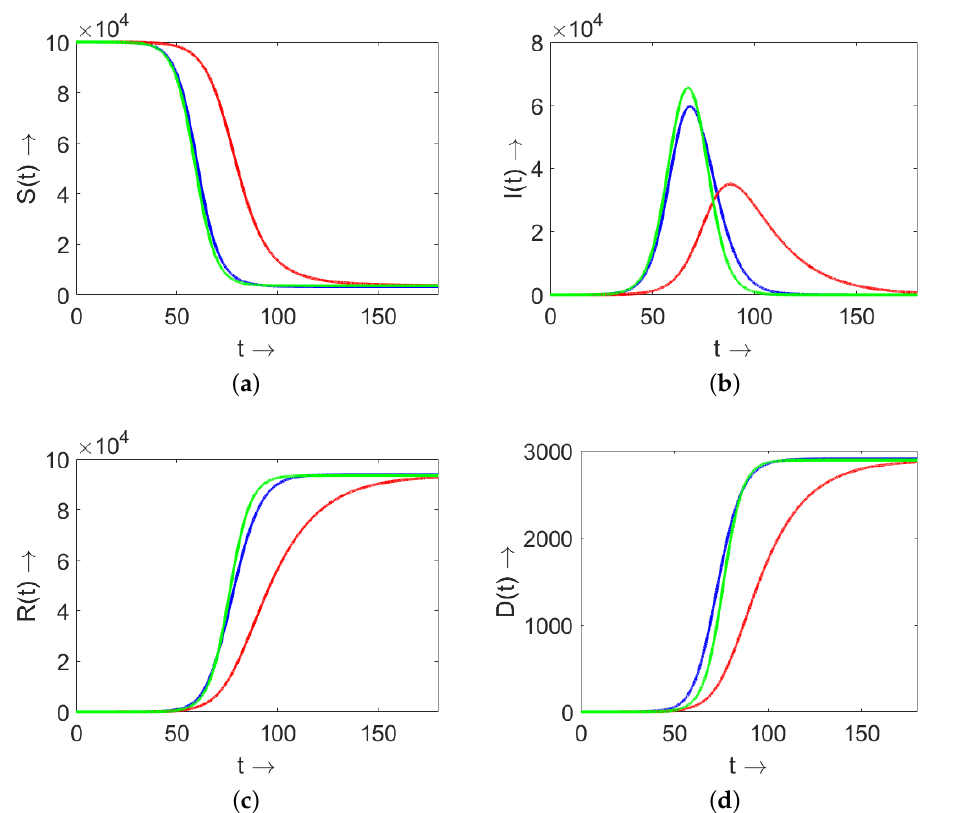
Figure 4. Comparison of the solutions of the distributed model (3) (blue curve), the delay model (9) (green curve), and the conventional SIR model (4) (red curve). ( a ) Susceptible S ( t ) , ( b ) infected I ( t ) , ( c ) recovered R ( t ) , and ( d ) dead D ( t ) . The values of parameters: N = 10 5 , I 0 = 1, β = 0.2, for the SIR model r 0 + d 0 = 1/17.7; for the delay model τ = 17.7; for the distributed model (3): a 1 = 8.06275, b 1 = 2.21407, a 2 = 6.00014, b 2 = 2.19887, p 0 =